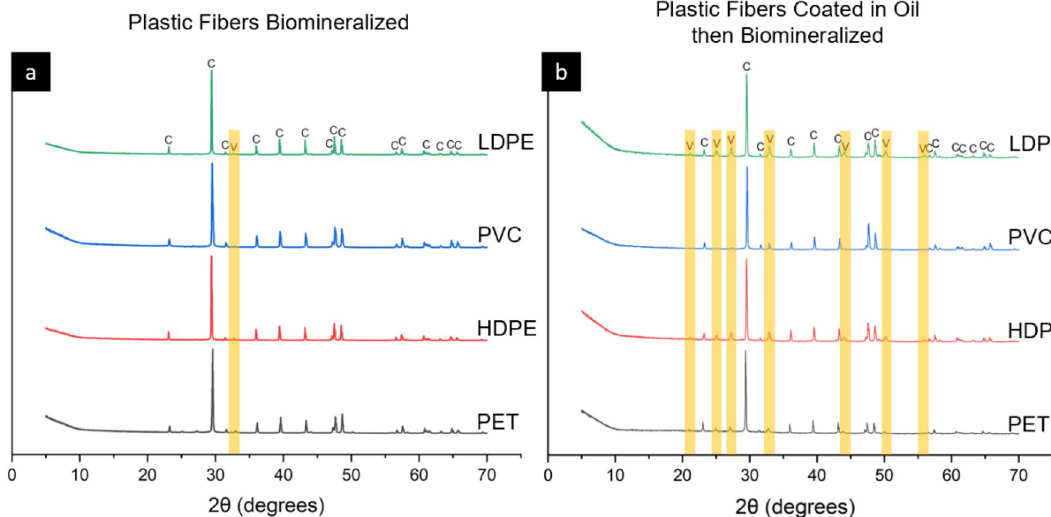
Figure 3. Mineralogy of all samples. ( a ) Mineralized plastic with no oil coating ( b ) Oil-coated and mineralized plastic. Vaterite peaks are